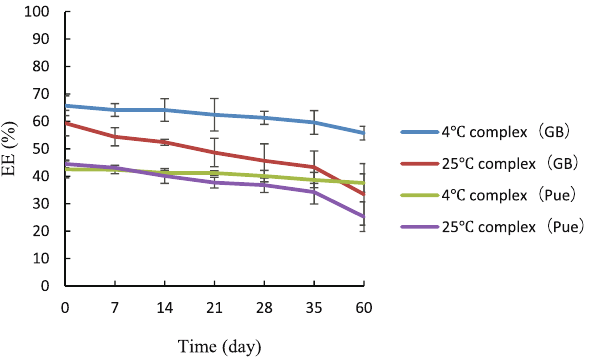
Figure 6: EE stability of GB and Pue in the niosomal complex